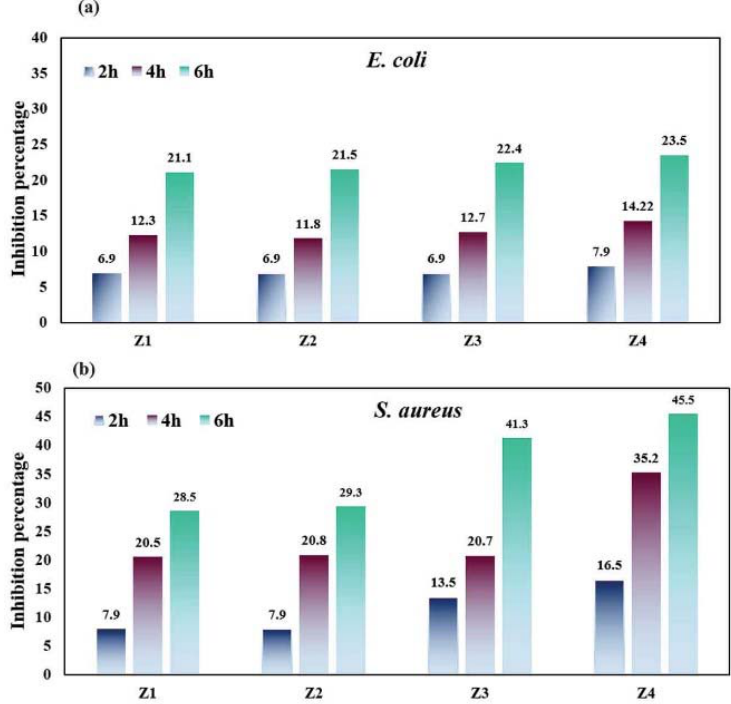
Figure 3. Bacterial growth inhibition rate against ( a ) E. coli and ( b ) S. aureus for the time exposed to 2 h, 4 h, and 6 h, respectively [35].